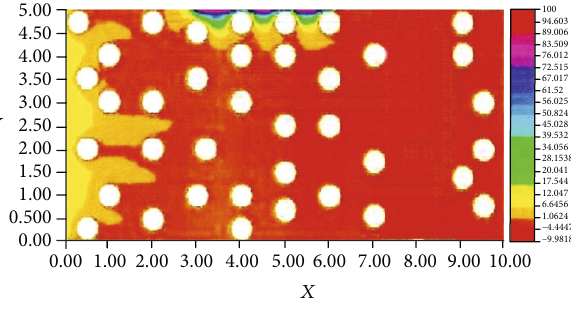
Figure 17: Concentration, D = 0 : 1 , C